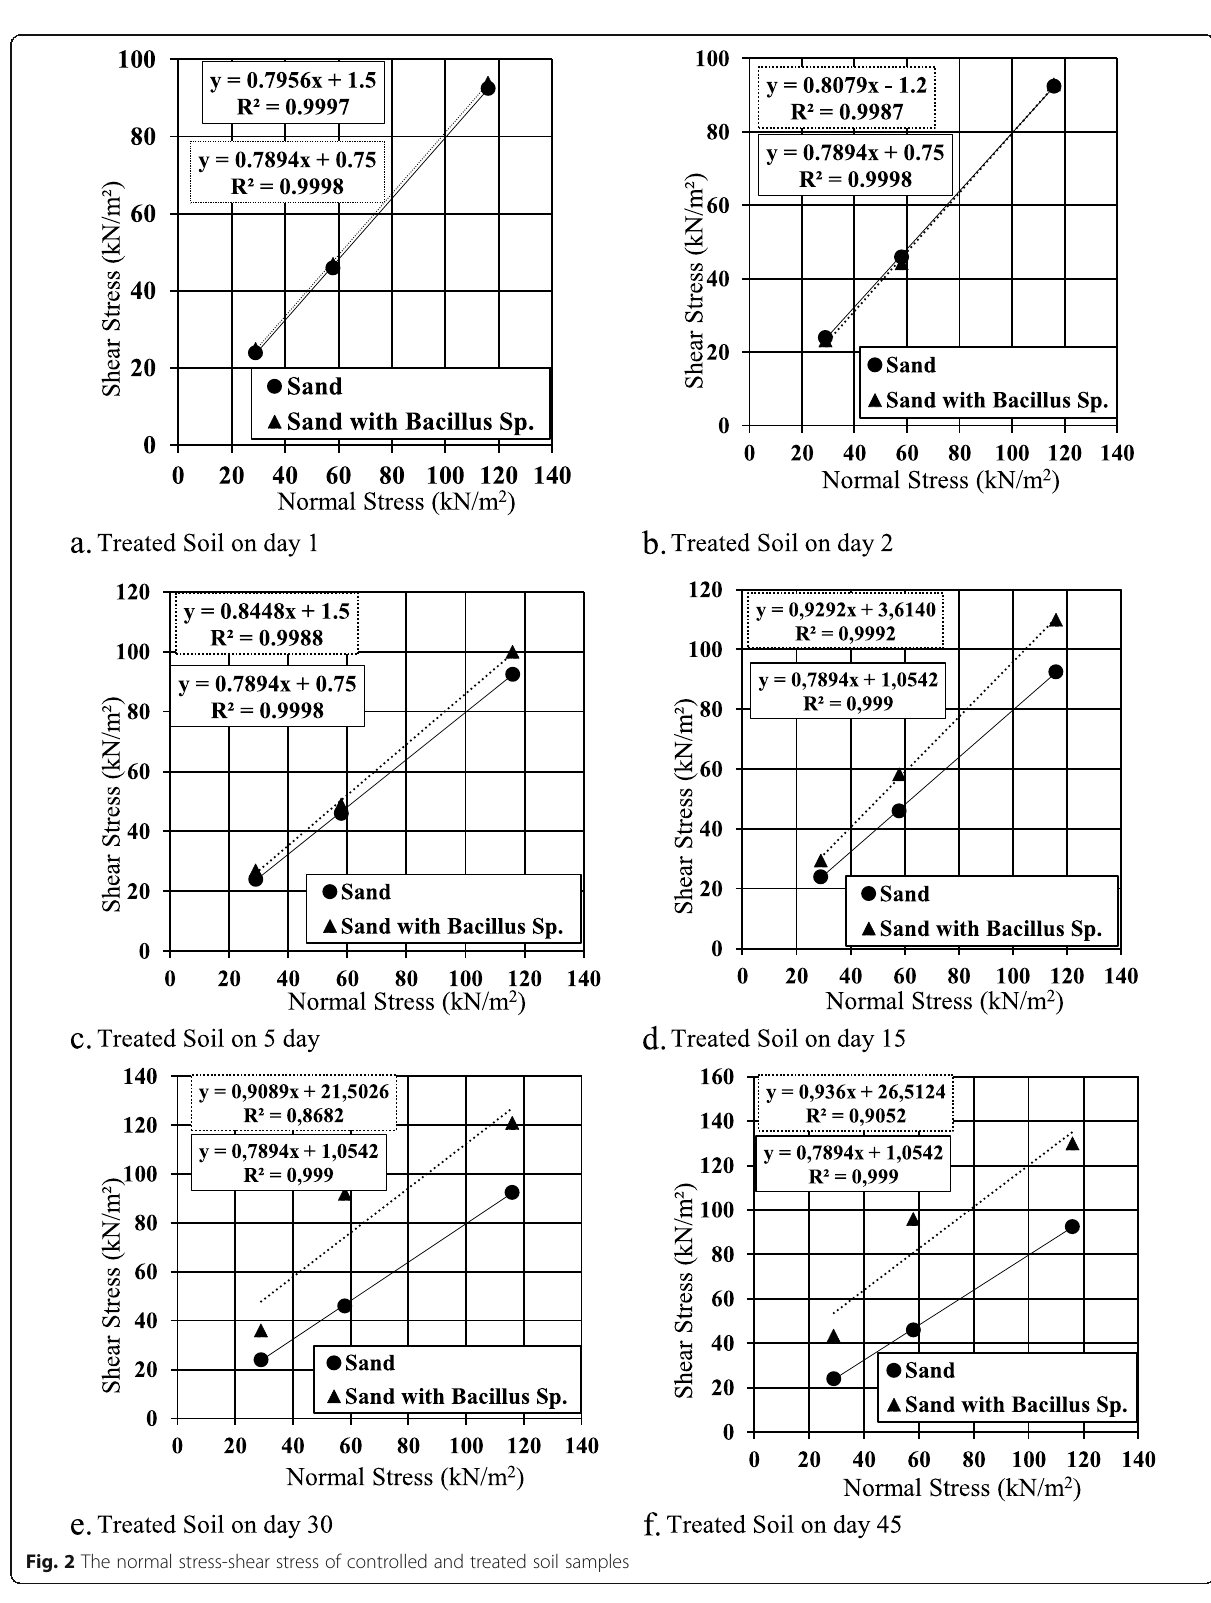
Fig. 2 The normal stress-shear stress of controlled and treated soil